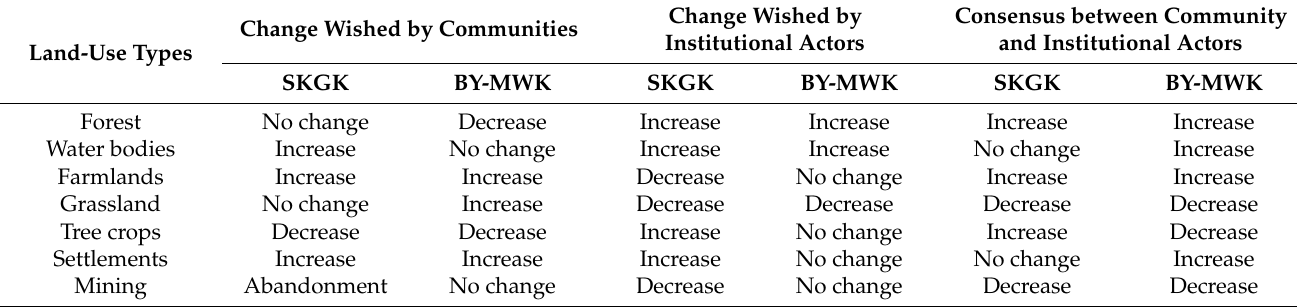
Table 3. Comparative table of changes desired by institutional and community